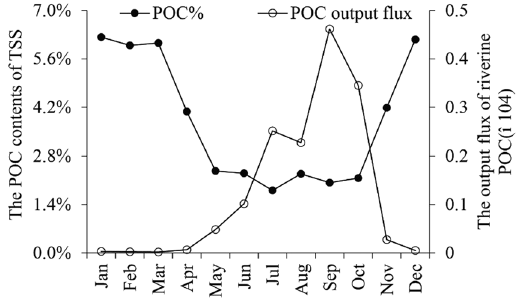
Figure 7. The monthly POC contents and output amount in